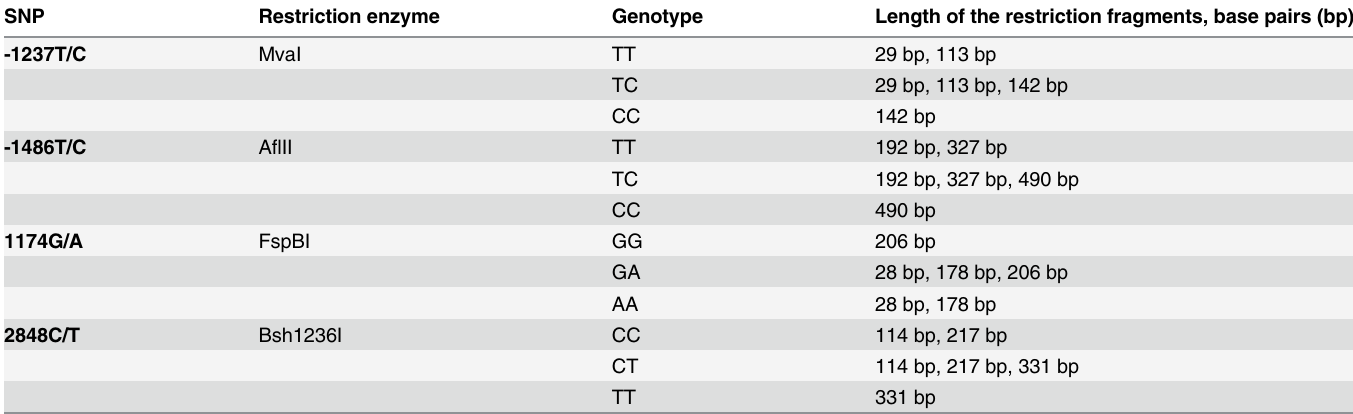
Table 2. Restriction enzymes and length of the restriction fragments.